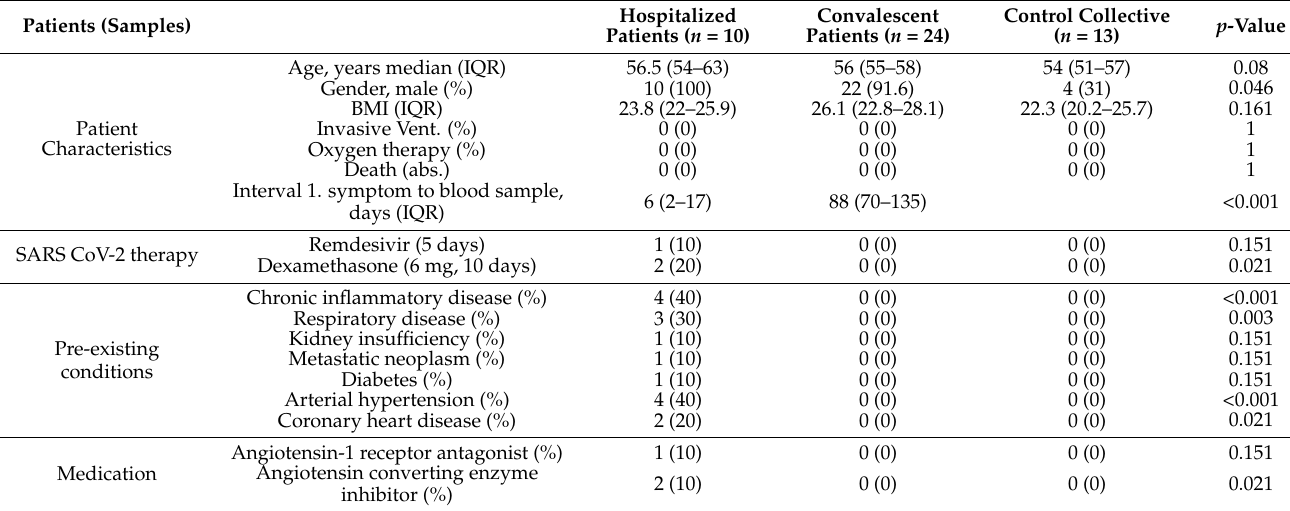
Table 1. Cohort characteristics: differences were calculated by Kruskal–Wallis test; IQR, interquartile range; BMI, Body Mass